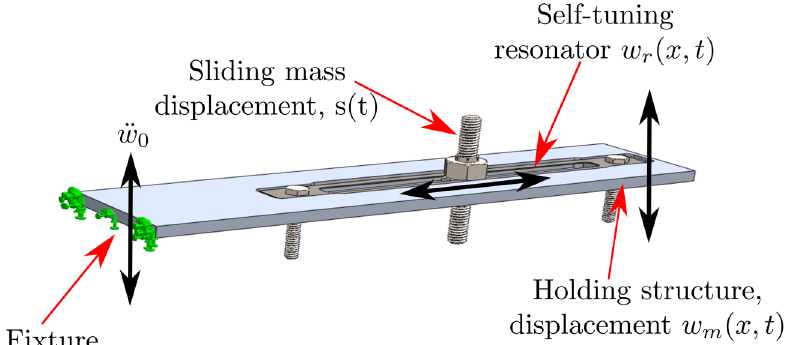
Figure 1. Key components of the self-tuning vibration absorber installed on a